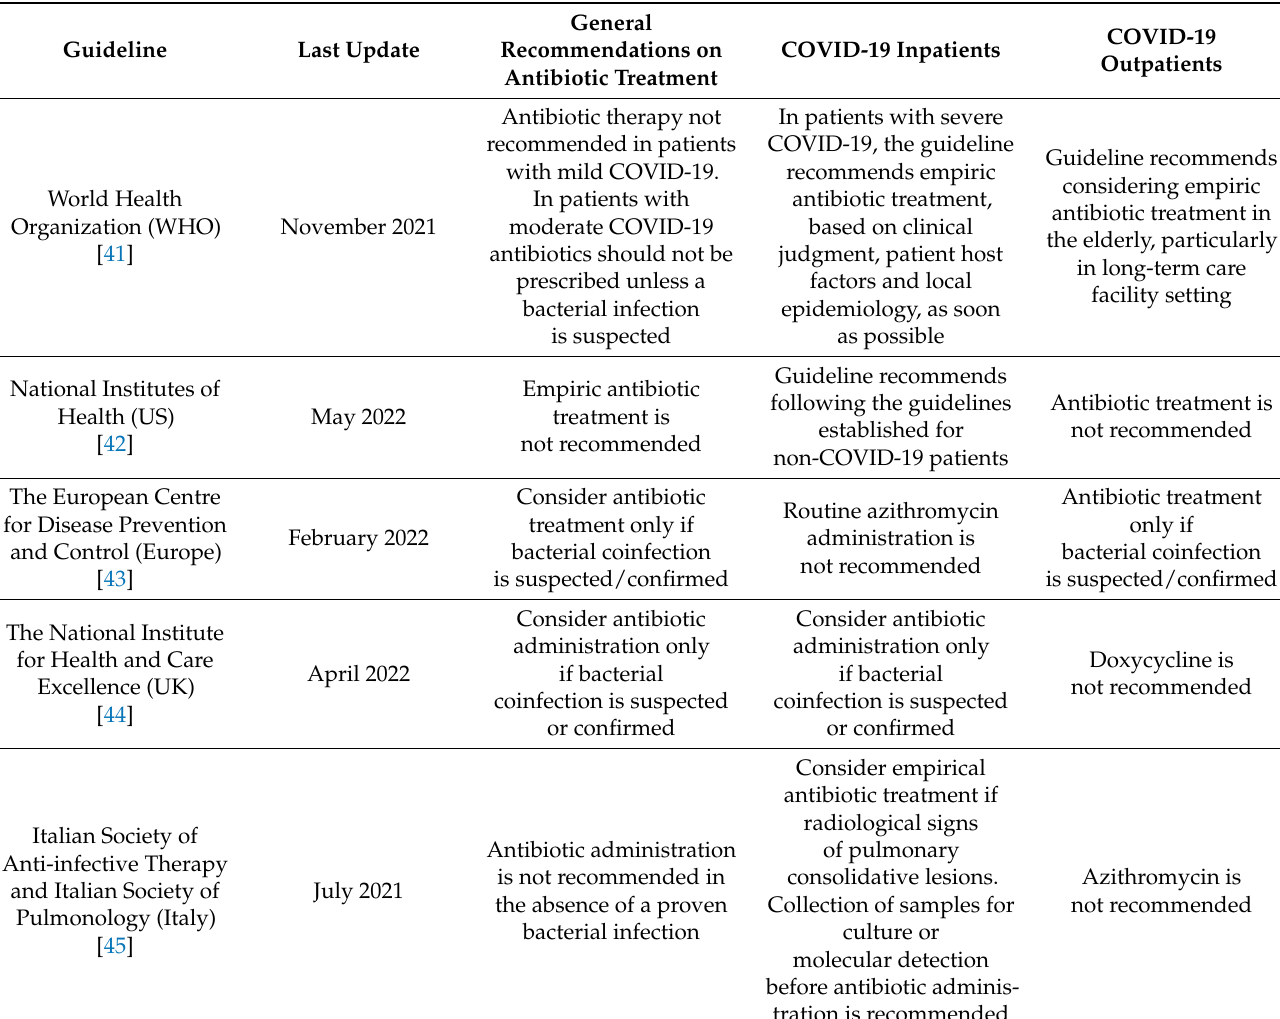
Table 4. Summary description of the clinical guidelines’ main recommendations on antibiotic treat- ment in COVID-19 inpatients and